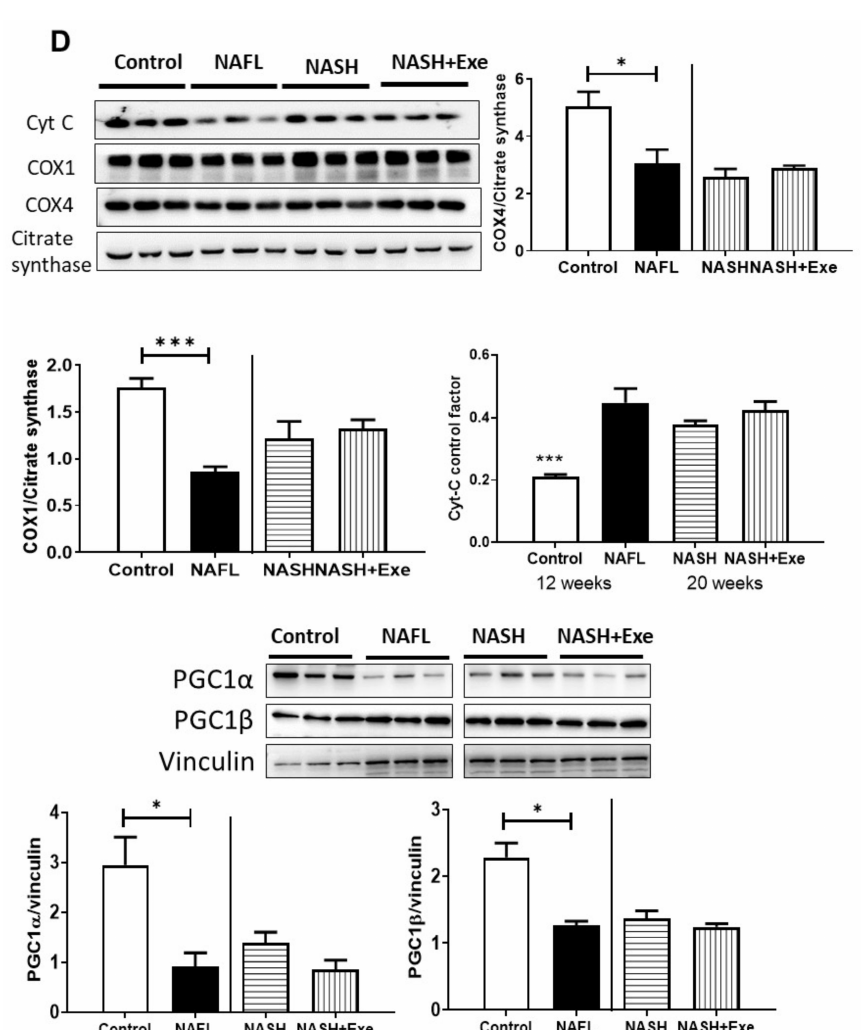
Figure 10. E ff ect of exercise on mitochondrial bioenergetics. ( A ) High-resolution respirometry of oxygen consumption (O 2 flux) in mitochondria isolated from livers of control vs. NAFL group (12-week treatment) (left panel) and NASH sedentary vs. NASH + EXE groups (right panel). O 2 flux was measured with an O2k Oroboros instrument. Mitochondria were exposed to sequential additions of pyruvate / malate, glutamate, succinate, ADP, cytochrome c , oligomycin, rotenone, antimycin A, TMPD, ascorbate, and azide. Coupled complex I- and complex II–driven, leak respiration, maximal respiration, and complex IV OCRs were recorded and normalized for protein ( n = 3 per group). ( B ) Comparison of cytochrome c control factors. The ratios were measured as the fractional change of O 2 flux after the addition of excess cytochrome c and calculated as (Flux CI + II cytc − Flux CI + II) / Flux CI + II cytc . The ratio was significantly elevated in NAFL and NASH groups relative to control. ( C ) Comparison of mitochondrial citrate synthase activity in control vs. NAFL group and NASH sedentary vs. NASH + EXE groups. Activity was normalized for mitochondrial protein and was higher in NAFL vs. control (one way ANOVA; * p < 0.05). ( D ) Immunoblot showing expression of cytochrome c and of cytochrome c oxidase (COX) subunits 1 and 4 in mitochondria. Citrate synthase served as the loading control. Cytochrome c and COX1 and COX4 were lower in NAFL vs. control groups. Expression of PGC1 α and PGC1 β was evaluated with vinculin as the loading control (unpaired t -test; * p < 0.05; ** p < 0.005; *** p < 0.001). For more details of Western blots, please view Figure